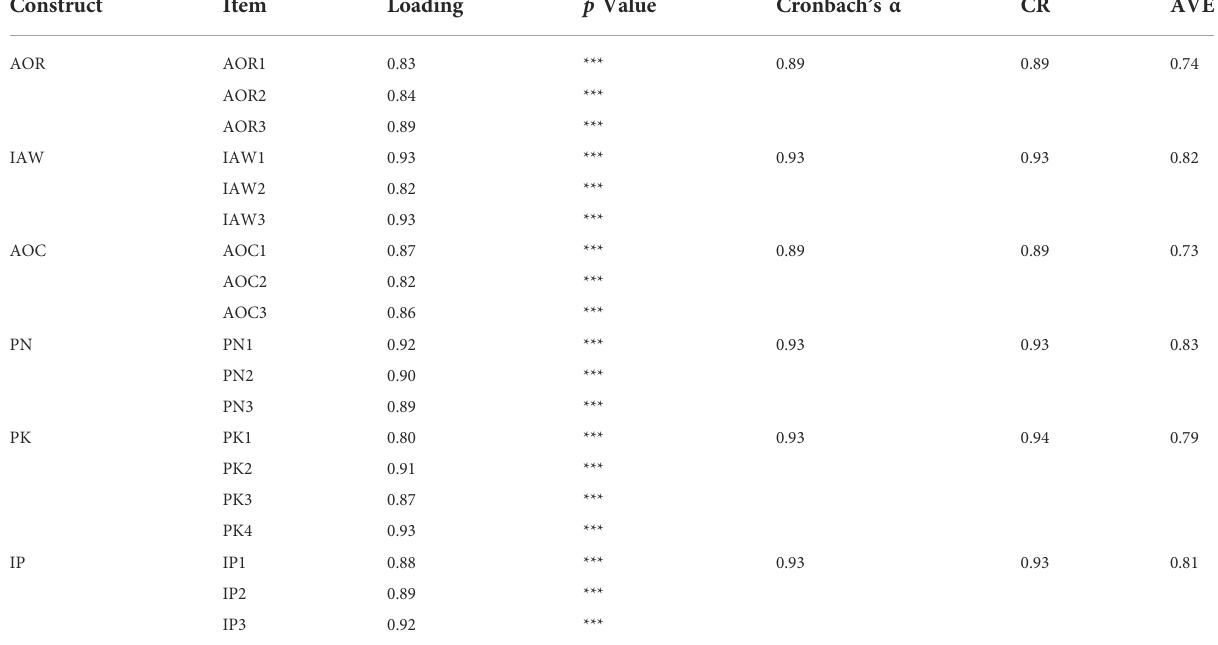
TABLE 2 Con fi rmatory factor analysis.